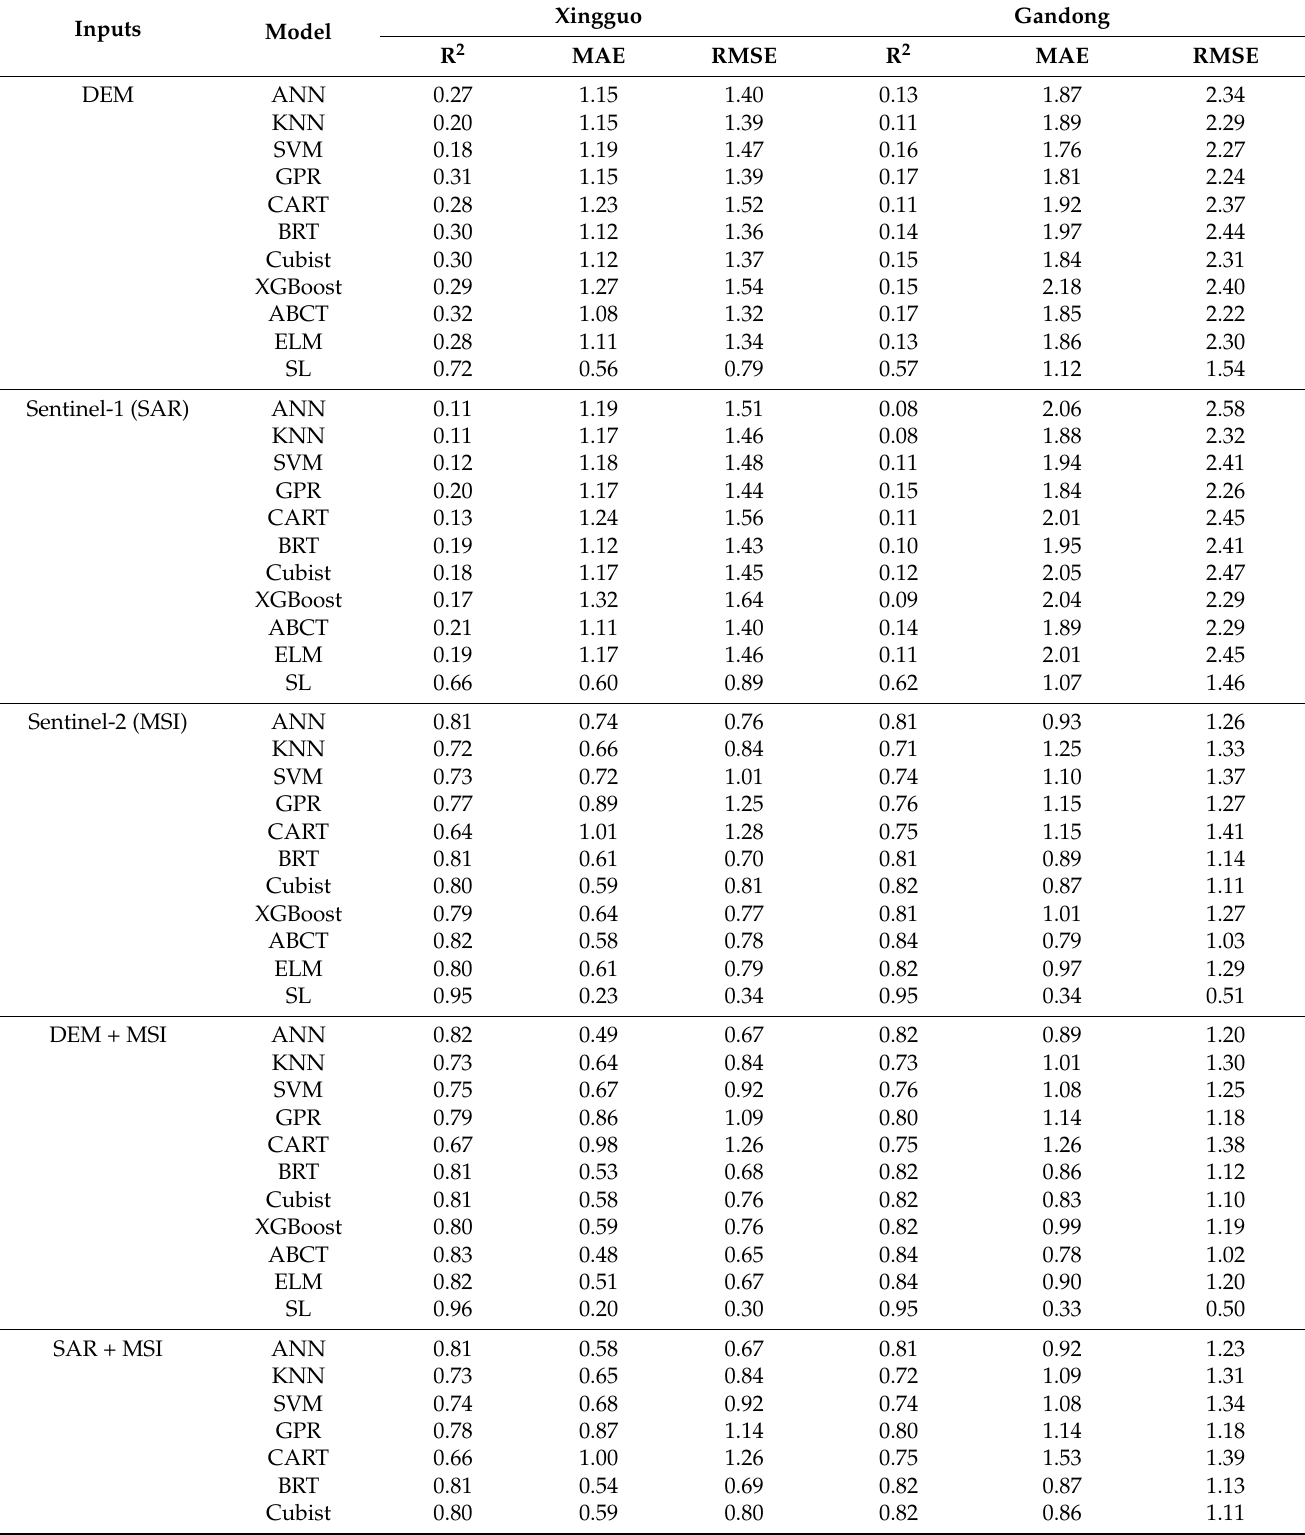
Table 5. The accuracies of accuracy comparison of the different machine learning models in Xingguo and